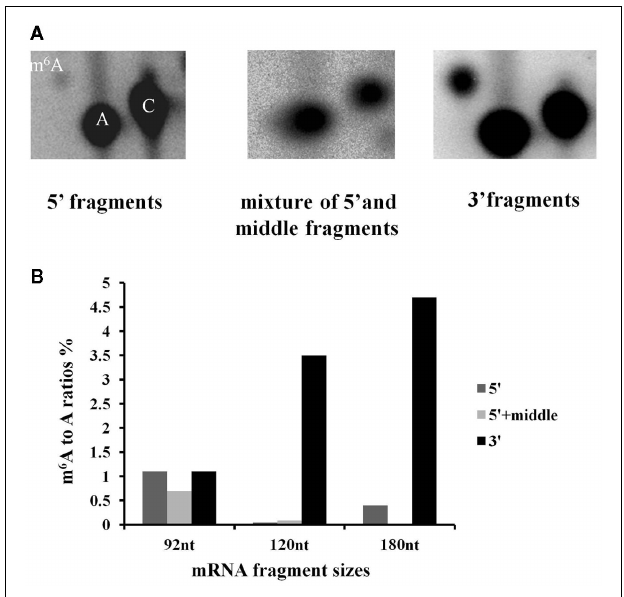
FIGURE 5 | N 6-methyl adenosine is enriched in the 3 (cid:2) end of transcripts. Fragmented high purity mRNA was fractionated into 3 (cid:2) , middle + 5 (cid:2) and 5 (cid:2) regions and the m 6 A content was measured for each fraction using the publishedTLC based method.The positions of m 6 A, A and C are indicated in the left hand panel.The spot corresponding to m 6 A is enriched on theTLC carried out on the 3 (cid:2) end, compared to the 5 (cid:2) and 5 (cid:2) + middle samples (A) . (The example is from mRNA fragmented to 180 nt).The graph shows the distribution of m 6 A for three different fragmentation experiments (B) .When the fragment size is 90 nt or less, m 6 A enrichment associated with polyadenylated fragments is no longer seen.